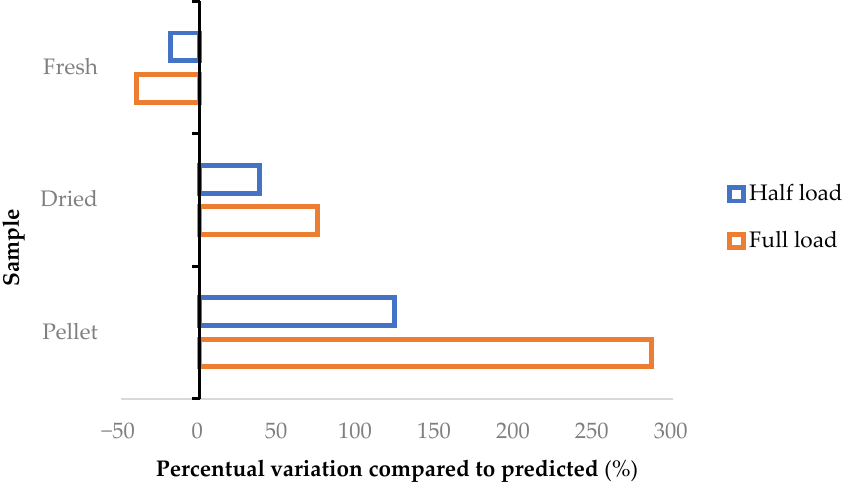
Figure 5. Percentage variation in mL of volatile fraction, according to the small-scale projections. In particular, pellet productivity was approximately quadrupled, reaching 10.80 mL VE /kg dry matrix (entry 16), from the 2.80 mL VE /kg dry matrix (entry 9) obtained from the small- scale process. Similarly, dry cones nearly doubled the overall outcome, increasing from 8.52 (entry 8) to 14.87 mL VE /kg dry matrix (entry 15).